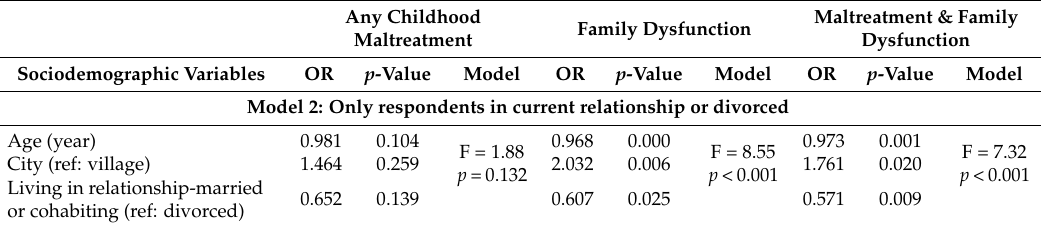
Table 6. Independent determinants of experiencing any of the five types of maltreatment or five types of dysfunctions in the family (Model 2 and Model